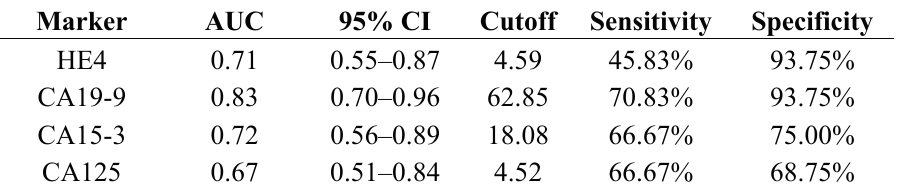
Table 3. The value of Area Under the Curve (AUC), Confidence Interval (CI), cutoff, sensitivity and specificity of four serum markers. The value of AUC, CI, cutoff, sensitivity and specificity for each marker (HE4, CA19-9, CA15-3 and CA125) were calculated, respectively, and shown in the table. CI is at 95% confidence interval (95% CI); Cutoff is the best statistical cutoff value.